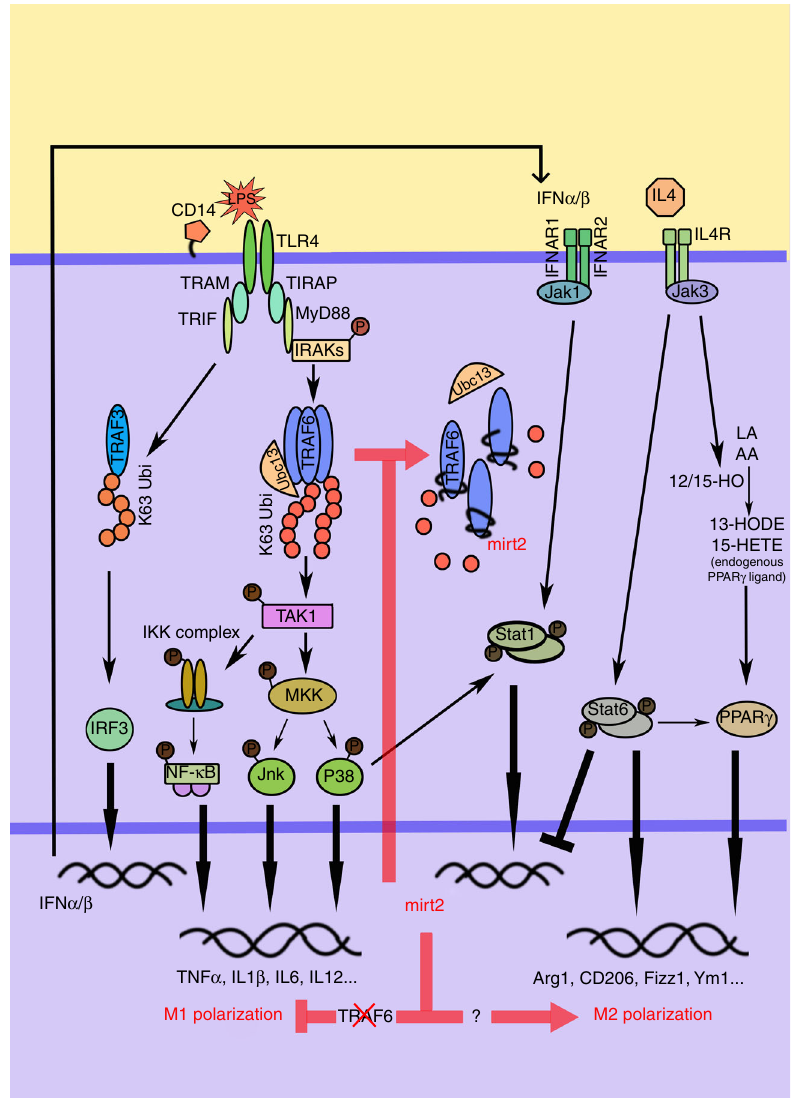
Fig. 9 Schematic of the molecular mechanisms of Mirt2 in in fl ammatory responses. Activation of LPS-p38-Stat1 and LPS-IFN- α / β -Stat1 pathways transcriptionally promotes the expression of lncRNA Mirt2, and Mirt2 speci fi cally inhibits the K63-ubiquitination of TRAF6, thus alleviating in fl ammatory responses after TLR4 activation and balancing macrophage